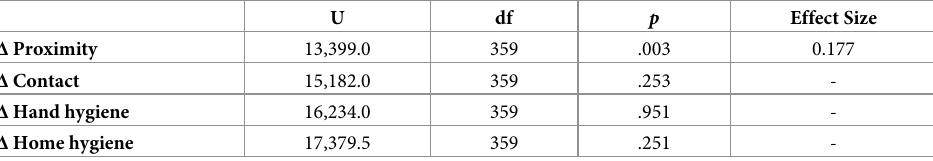
Table 4. Results of rank-sum tests of gender differences in changes in mitigation